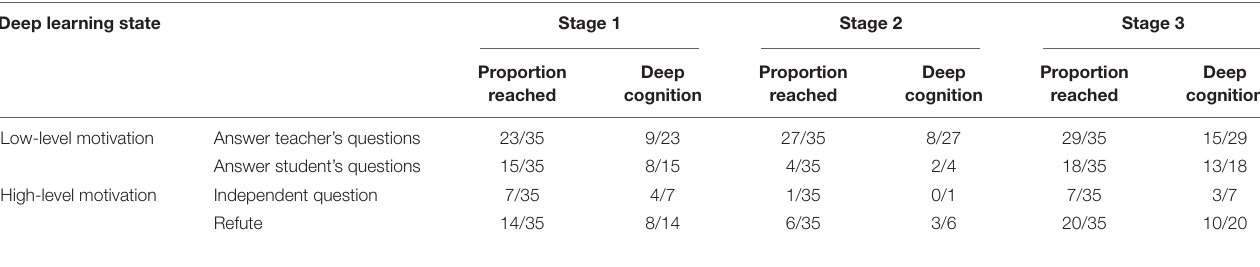
TABLE 3 | Three-stage classroom record of students in a flipped classroom mode. Deep learning